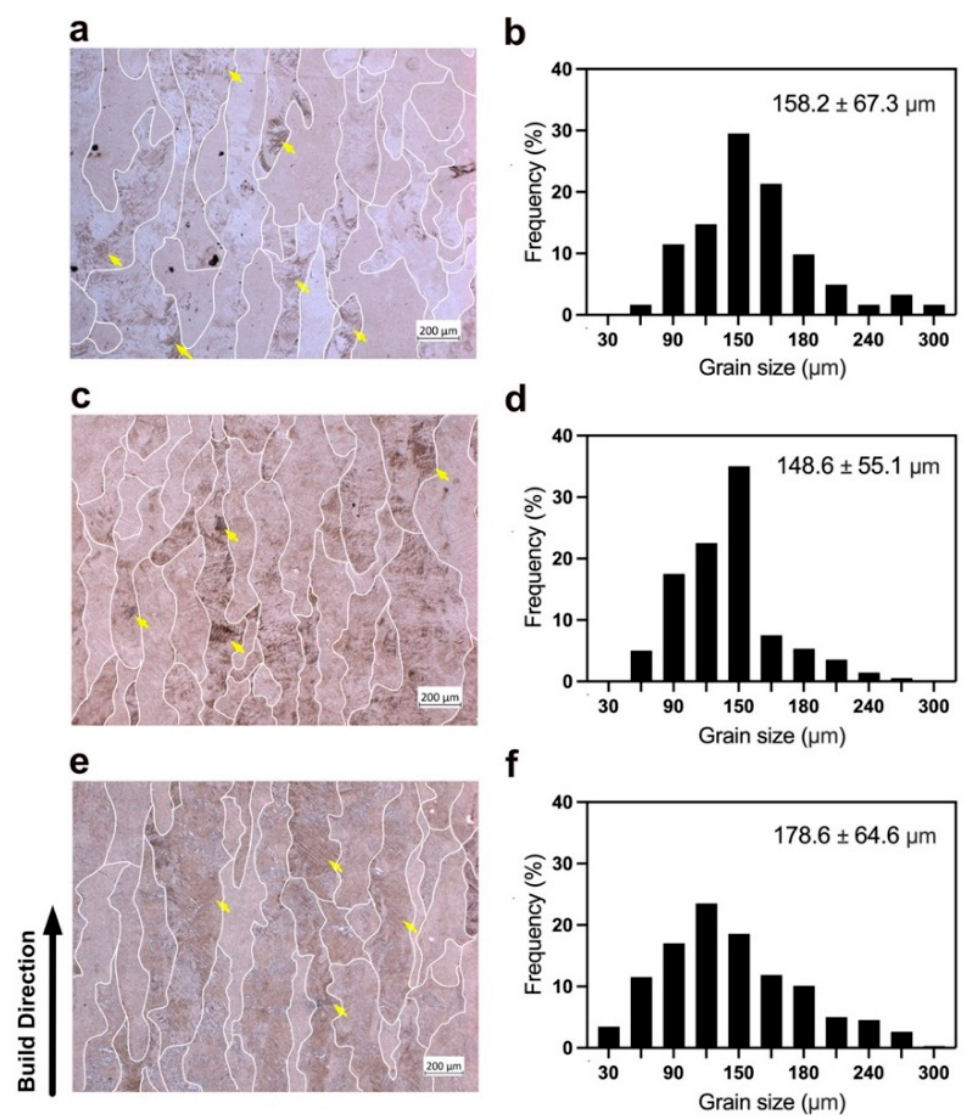
Figure 4. Representative optical microscopy images of ( a ) 750-WQ sample, ( c ) 750-AC sample, ( e ) 750-FC sample. The prior β grain boundaries in ( a , c , e ) are traced by white-color lines. The histograms of prior β -phase grains size are shown in ( b , d , f ).